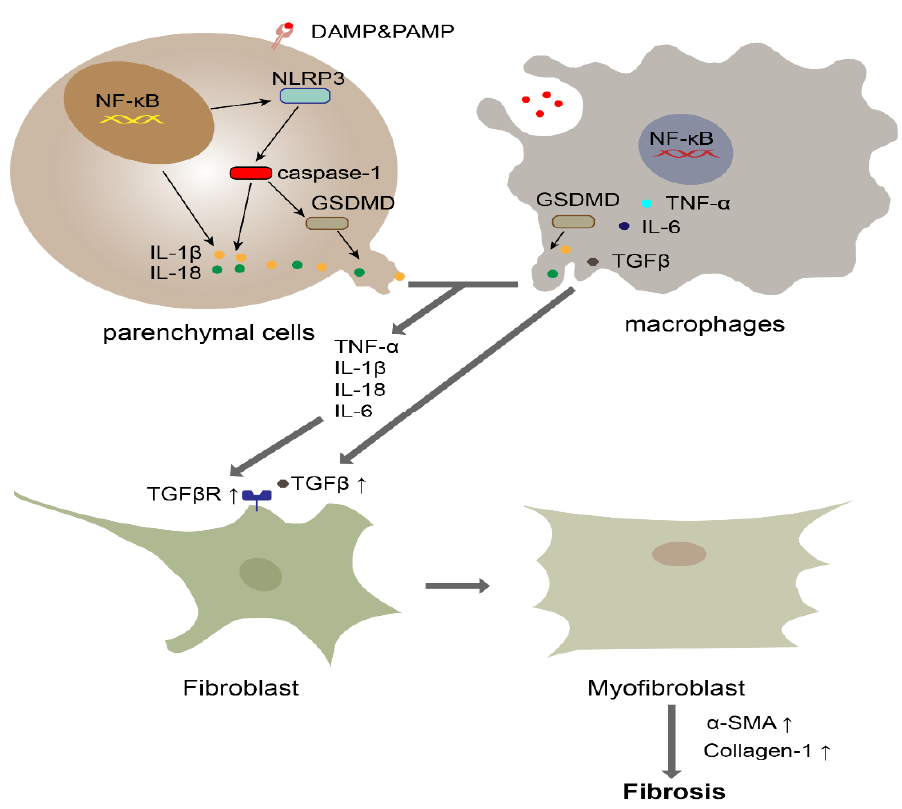
Figure 2. The role of pyroptosis in fibrosis. Macrophages and parenchymal cells, such as hepatocytes and alveolar epithelial cells, initiate the NF- κ B pathway when they recognize DAMPs or PAMPs. Subsequently, upregulated NLRP3 activates caspase-1. Activated caspase-1 cleaves GSDMD into GSDMD-N, which oligomerizes to form the pyroptotic pore. The released IL-1 β , IL-6, IL-18 and TNF- α promote the increased expression of the TGF receptor. Meanwhile, macrophages secrete TGF to cause the differentiation of fibroblasts into myofibroblasts. Subsequently, myofibroblasts induce substantial collagen deposition.